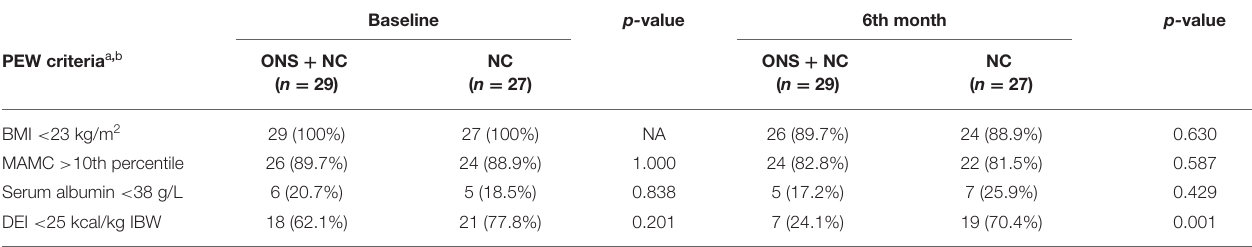
TABLE 3 | Effect of treatment on PEW criteria status. Baseline p- value 6th month p- value